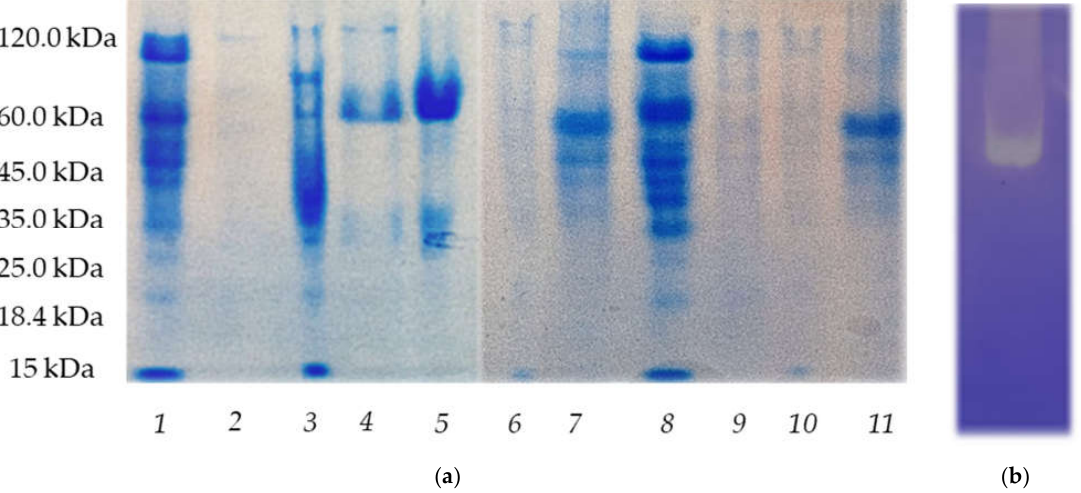
Figure 5. ( a ) SDS-PAGE analysis of proteinase preparations obtained from the cultural fluid of micromycetes from Tolypocladium genus 1—k1 (glycerol), 2—126a (starch), 3—49a (glycerol), 4—14a (glycerol), 5—30a (glycerol), 6—49a (starch), 7—13a (glycerol), 8—62a (glycerol), 9—150a (starch), 10-150a (glycerol), and 11-126a (glycerol). ( b ) Fibrin zymogram of extracellular proteinases of Toly- pocladium inflatum 62a.